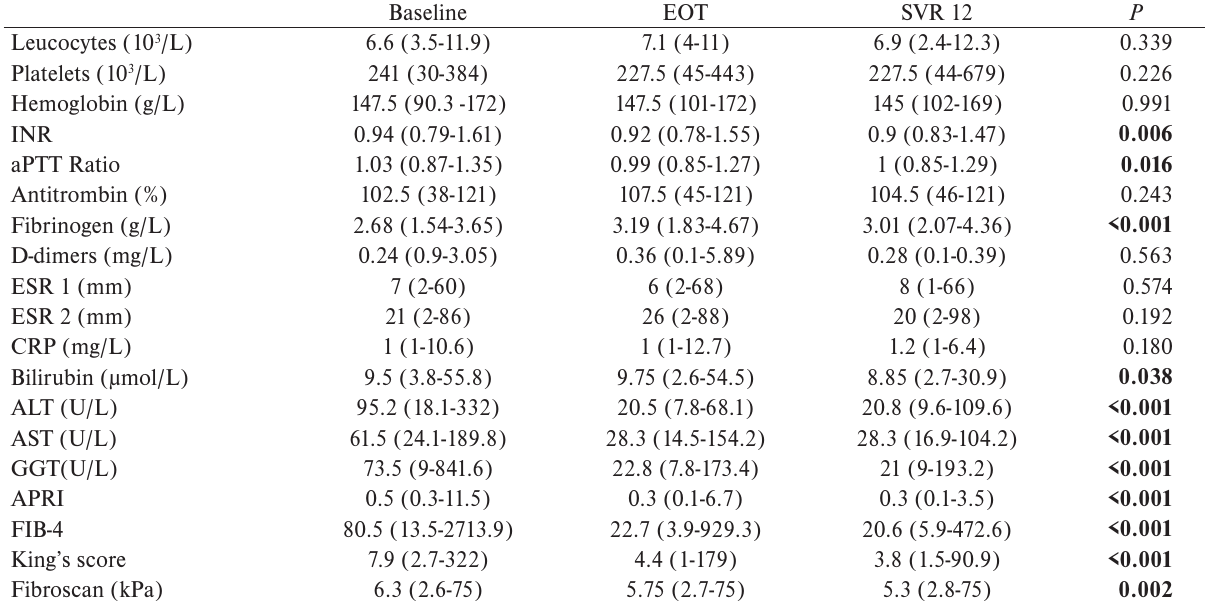
Table 2. Laboratory test and elastography results at baseline, EOT, and